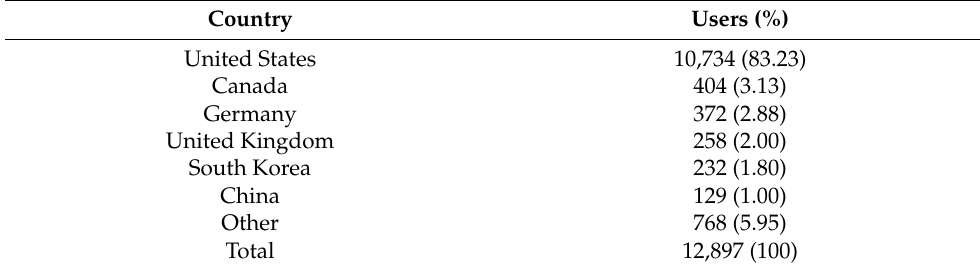
Table 1. AIN usage by country.